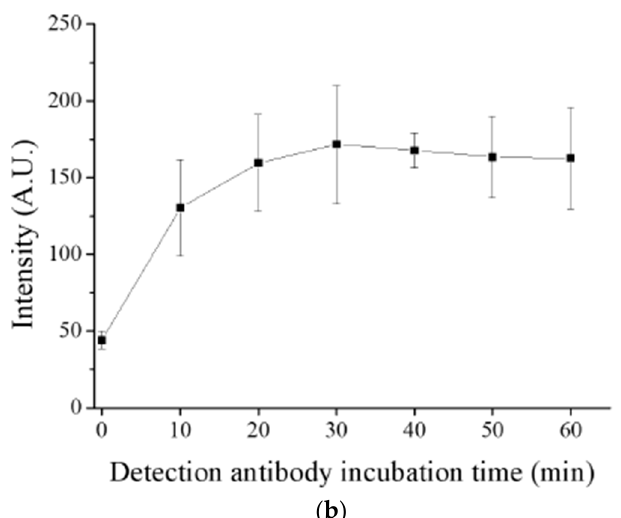
Figure 4. Optimization of incubation time for antigen–antibody interaction. ( a ) Change the incubation time for p53 antigen and anti-p53 antibody interaction, ( b ) change the incubation time for anti-p53 antibody and HRP-conjugated anti-mouse IgG interaction. All immunoassays were carried out with triplicates at fixed anti-p53 antibody and HRP-conjugated anti-mouse IgG concentrations.